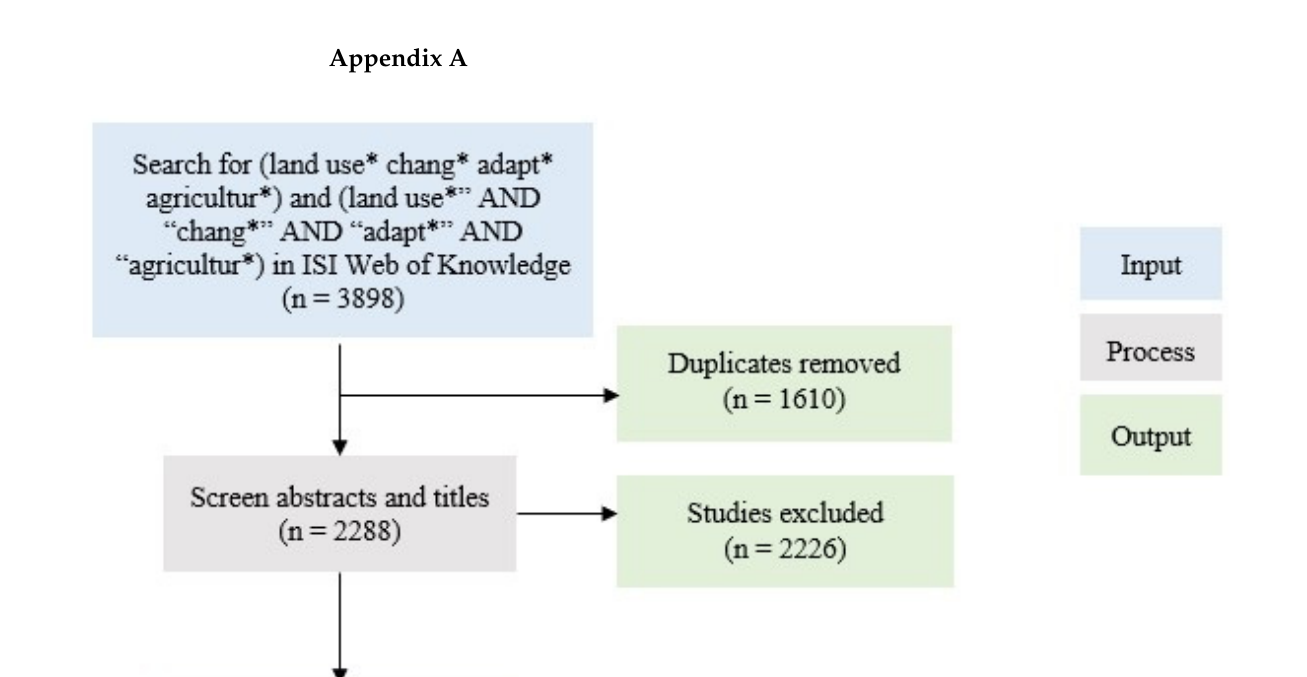
Figure A1. PRISMA Search Flow Chart.